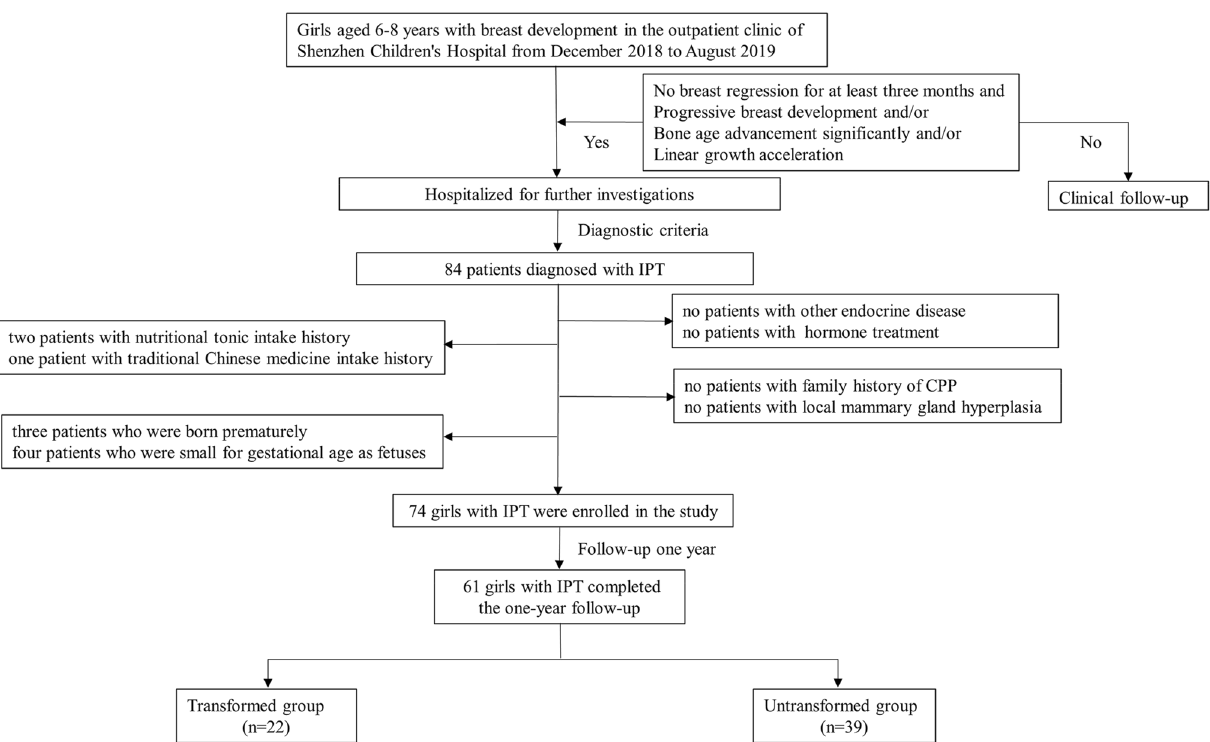
Figure 1. Flowchart of the study population selection process. IPT isolated premature thelarche, CPP central precocious